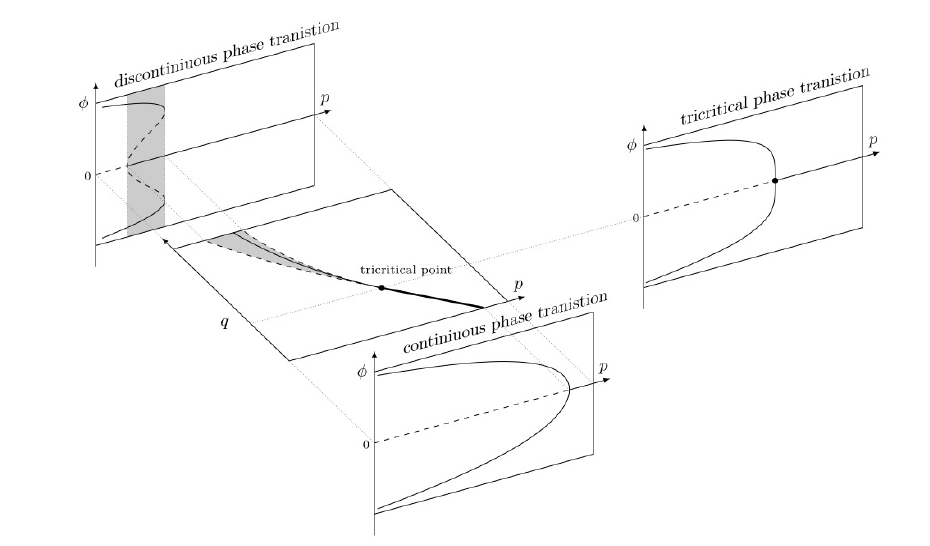
Figure 4. Phase transition diagram of φ (borrowed from